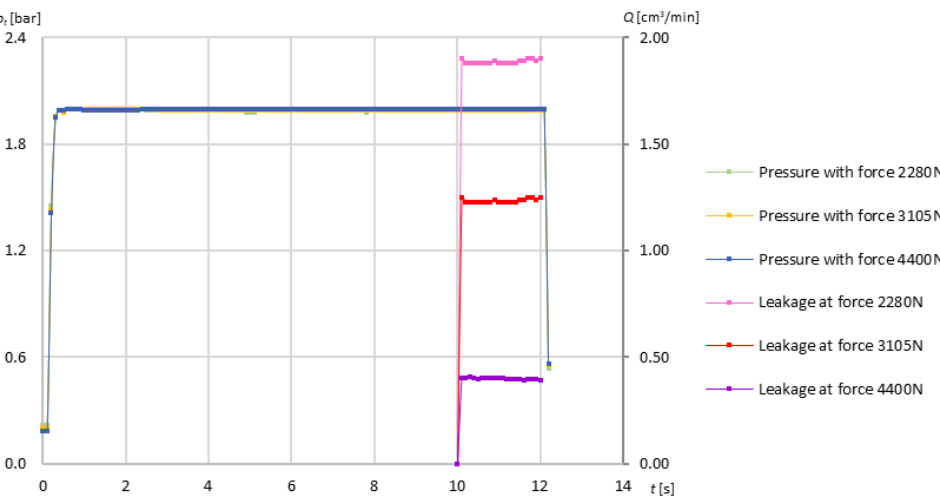
Figure 10. A diagram of dependence for a pair of samples 6–8, with surface topography parameters from code groups A and B, for a variable clamping force. Table 8. Forces and leakage for a pair of samples with surface topography parameters from code groups A, C, D, E, and F.